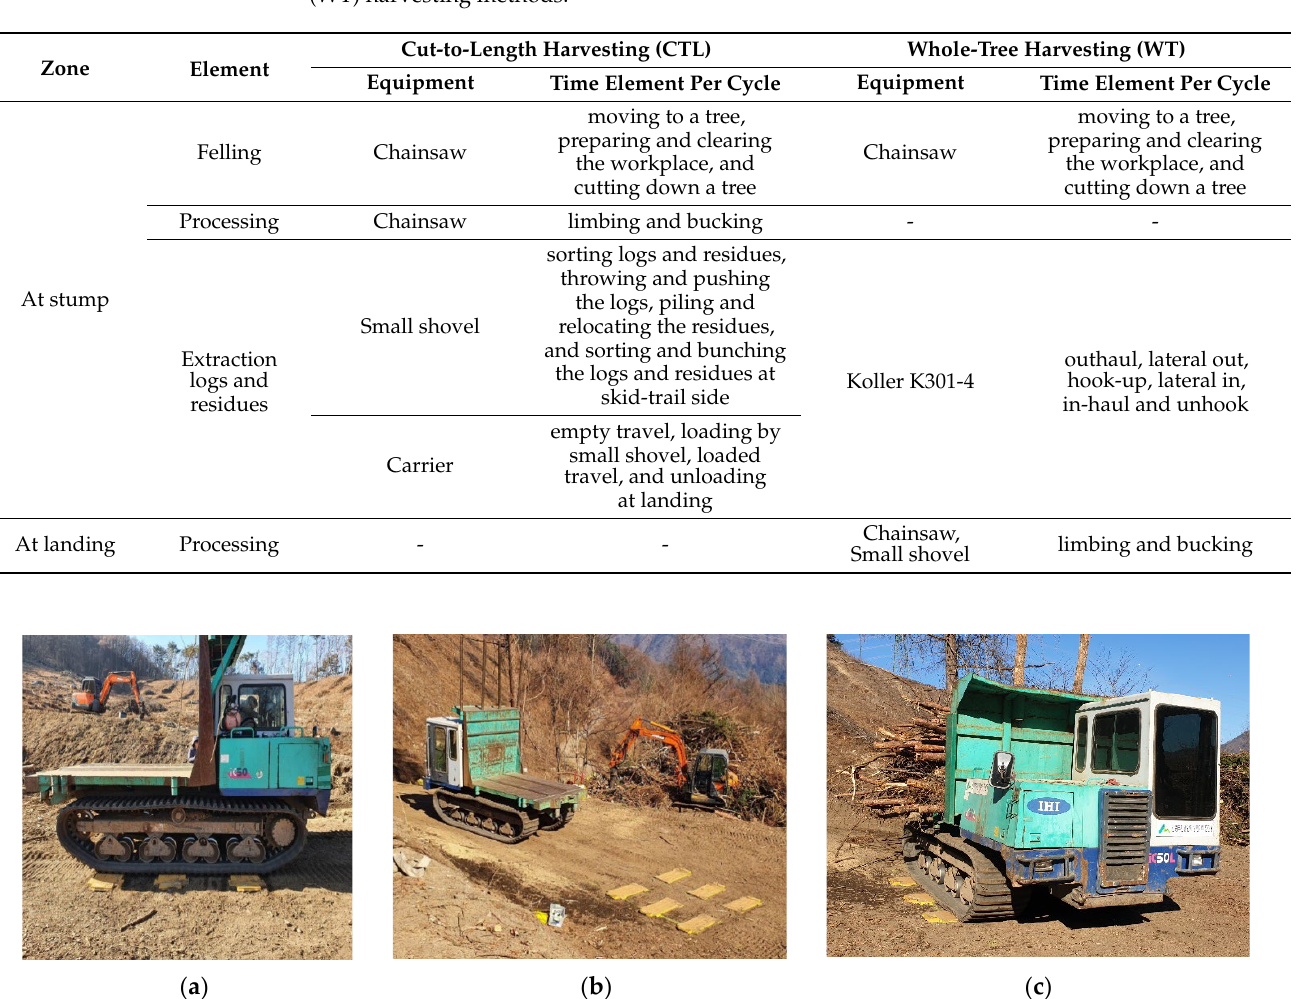
Table 3. The time elements measured during the time study for the cut-to-length (CTL) and whole-tree (WT) harvesting methods.